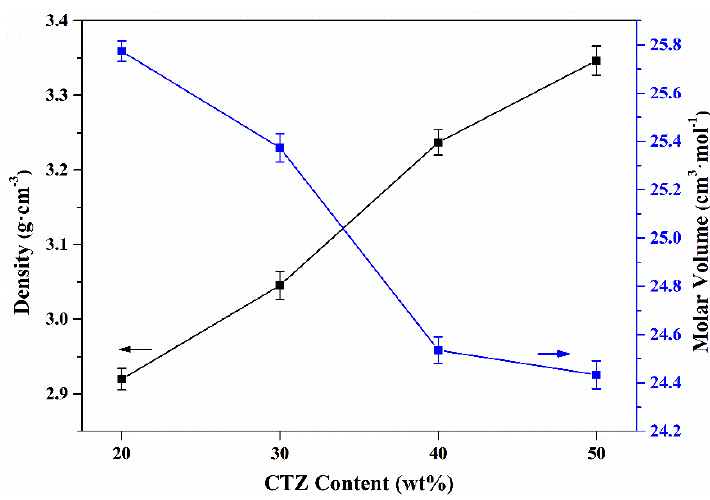
Figure 8. Bulk densities and molar volumes of the glass-ceramic samples.